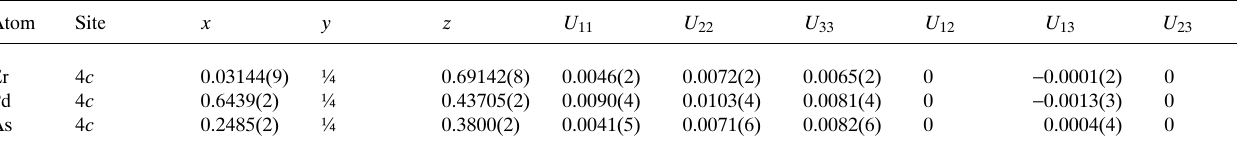
Table 2. Atomic coordinates and displacement parameters (in Å 2 )